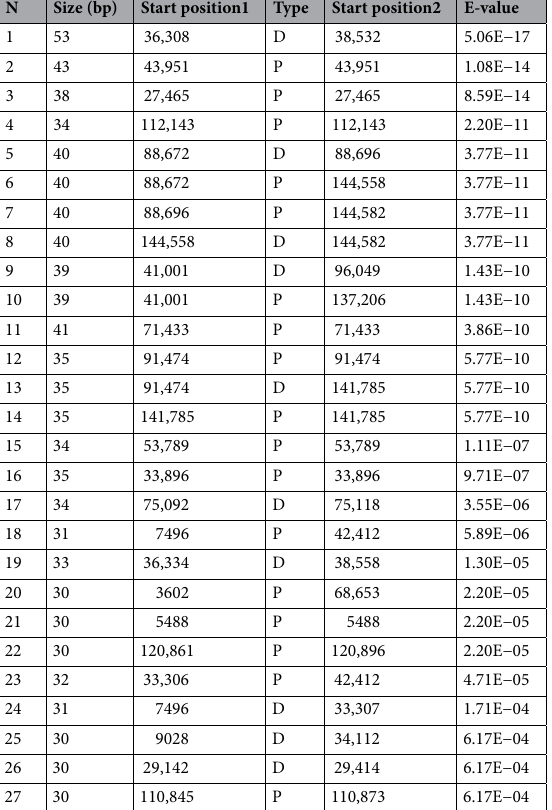
Table 2. Dispersed and palindromic repeats by positions in the cp genome of L. ledebourii